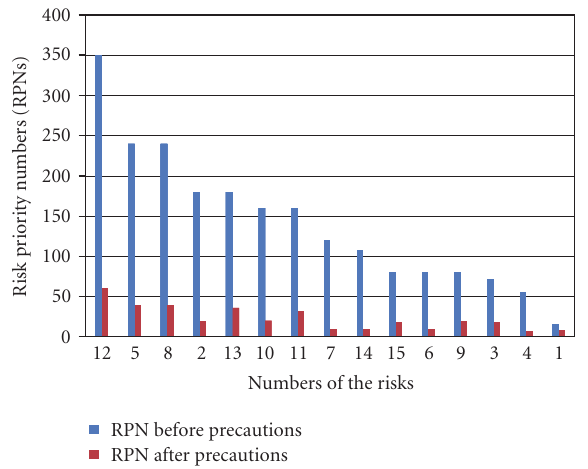
Figure 3: Risk priority numbers before and after the preventive measures. 12: the mother who is given patient-controlled analgesia (PCA) drops the baby when she stands up by herself while no one is near; 5: infant may slip down from the hands of the doctor during delivery; 8: after having the first medical examination (Apgar scores and general condition fine) the newborn may fall due to turning over of the baby cot while it is being transferred to the baby room to be placed in the incubator in the operating room or in the baby cot in the delivery room; 2: birth may occur by standing up and straining of the patient when the cervix is dilated 5cm or more; 13: during the day the infant is taken to baby room by the baby nurse for checking vital findings, changing diaper, and doctor’s examinations; 10: the infant cared for and dressed is placed in the baby cot and handed to the mother; 11: the mother picks up the infant to breastfeed it. Risk factors regarding the mother are analyzed; 7: the newborn may fall while it is taken to the newborn care unit for the first medical examination; 14: blood sample of the infant is taken to test for phenylketonuria and/or bilirubin on the day of discharge. While final preparations are being made the infant may slip down from the baby care unit; 15: after the mother is given the necessary instructions and while they are being discharged, the infant may slip down from the mother’s hands; 6: infant may slip down while the umbilical cord is cut; 9: the infant may slip down from the hands of the nurse while it is being transferred to the baby care room in an incubator or baby cot to baby care room; 3: patient may give birth in the preparation room before the doctor arrives; 4: birth may occur while the patient is being transferred to the delivery room; 1: patient is admitted to the service to be prepared for the